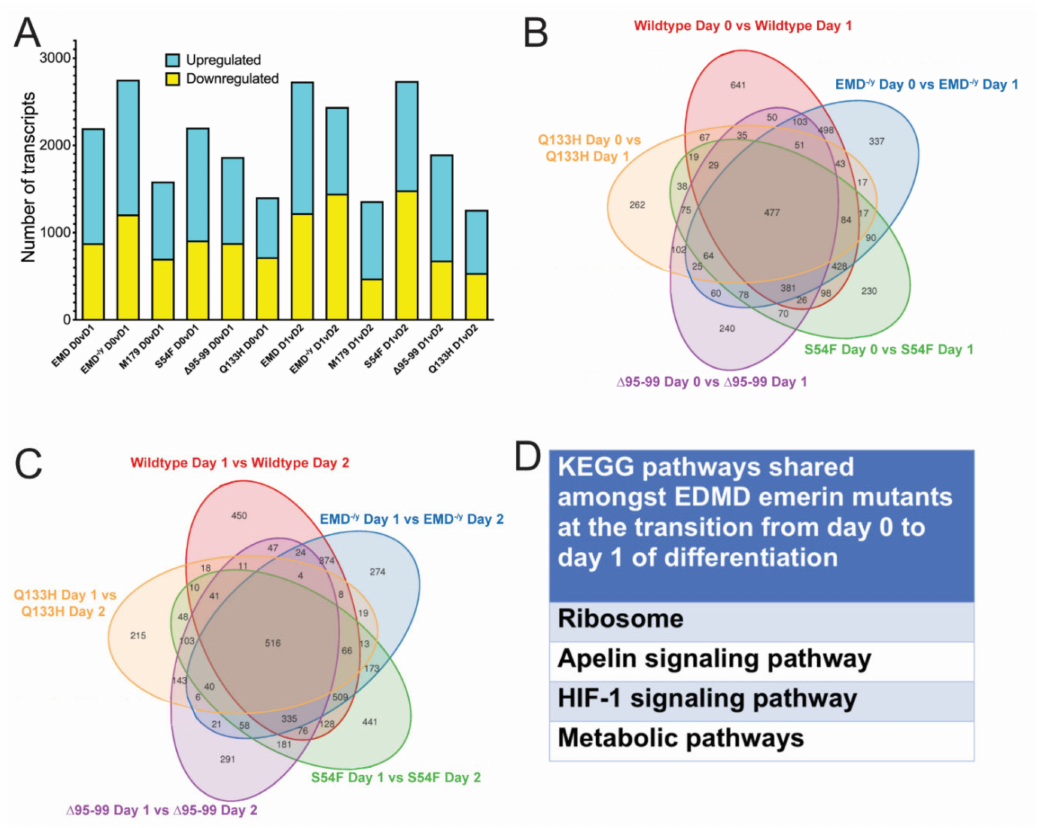
Figure 7. Significant changes in the transcriptome are seen at each daily transition during di ff erentiation of EDMD mutant myogenic progenitors. ( A ) Di ff erentially expressed transcripts were identified by comparing di ff erentiation day 1 to di ff erentiation day 0, or di ff erentiation day 2 to di ff erentiation day 1 in + EMD cells, EMD − / y cells, or each EDMD mutant myogenic progenitor at each transition. Blue —upregulated transcripts; Yellow —downregulated transcripts. ( B , C ) Venn diagrams illustrating di ff erentially expressed genes shared between wildtype, EMD − / y , and one or more EDMD mutant myogenic progenitors at the day 0 to day 1 transition, B, or day 1 to day 2 transition, C. ( D ) KEGG pathway analysis showing pathways enriched in EDMD emerin mutants, but not present in + EMD progenitors at the day 0 to day 1